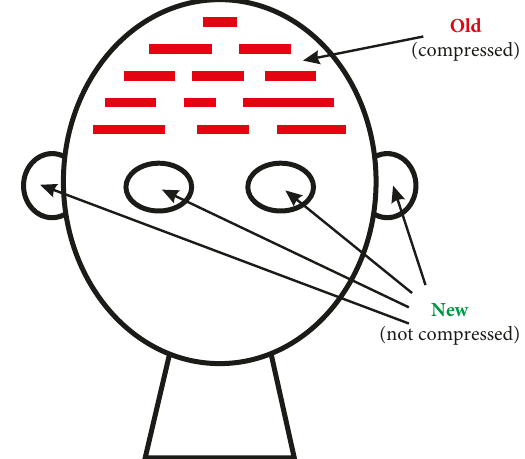
Figure 1: Schematic representation of the SP System from an “input” perspective (adapted from Figure 1 in [21], with